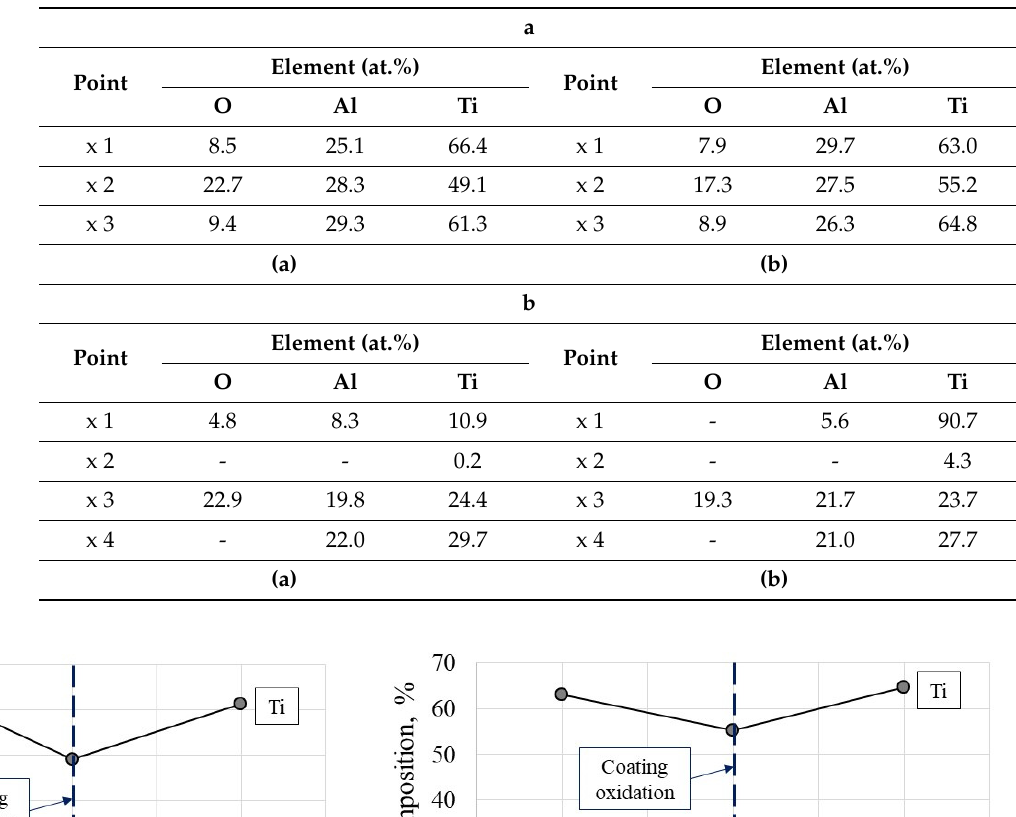
Table 5. a: ( a ) EDS analysis results in points 1, 2 and 3 on the flank face marked in Figures 8b and 9b.